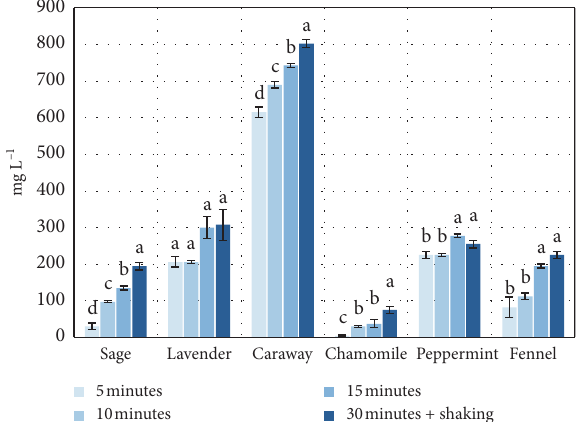
Figure 3: Concentration of essential oils in primary herbal brews (mg · L − 1 ). Data are shown as mean ± SD. Different letters (a, b, c, etc.) show a significant difference with p < 0 . 05.